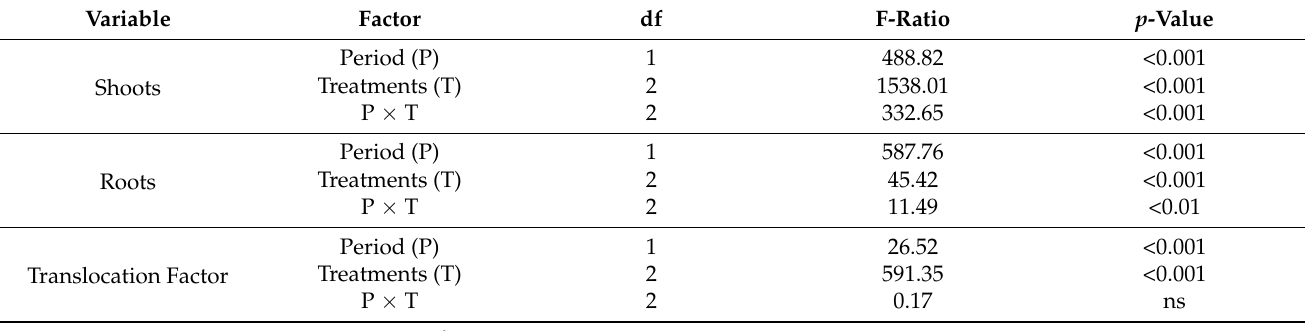
Table 1. Results of two-way ANOVAs showing the effects of different paracetamol treatments, exposure periods, and their interactions on the concentration of paracetamol ( µ g/g DW) in spinach shoots, roots, and translocation factor.